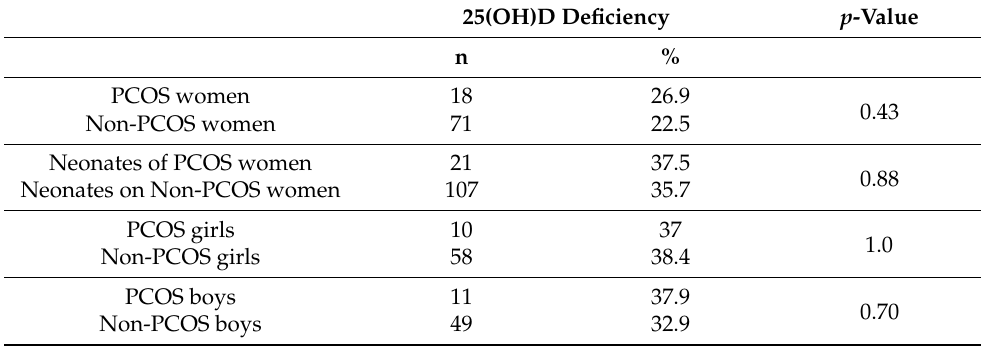
Table 1. 25(OH)D deficiency (<20 ng/mL); variables were analyzed by using Fisher’s exact test.